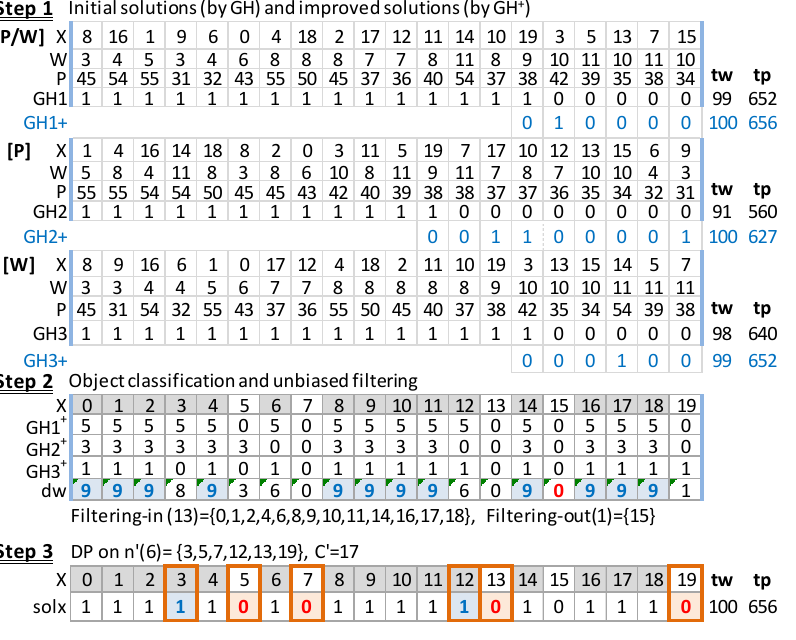
Figure 3. An example of 0/1-KP solving ( n = 20, C = 100) by TS Reduction (Algorithm 4), soltp = 656 (optimal). Algorithm 4: Time-space reduction for 0/1-KP in O( n + C’ ).